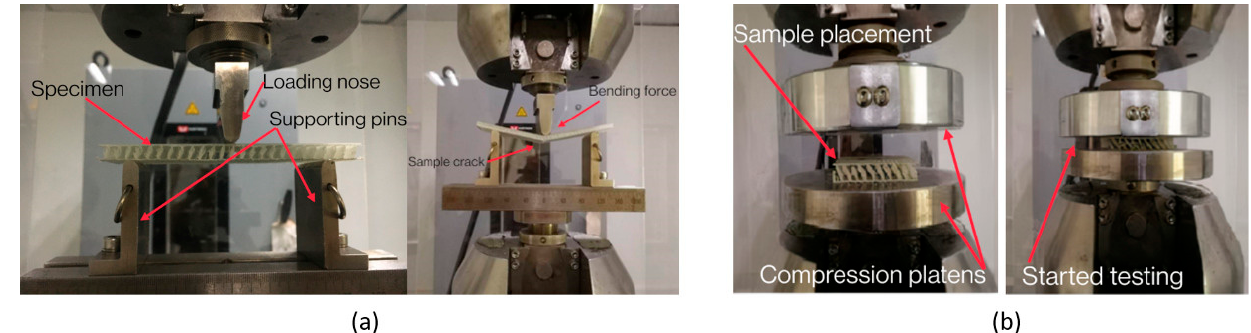
Figure 4. Equipment set ups for ( a ) bending and ( b ) flat compression experiments. At present, there is no unified test standard for testing the flat compression perfor- mance of glass fiber 3D spacer fabric composites in the industry. In this study, GB/T 1453-2005 “Sandwich structure or core flat compression performance test method” was selected based on the material characteristics and experimental equipment [17]. According to the standard, the test specimens were cut to a size of 60 × 60 mm. Five pieces were prepared for each group of standard specimen, as shown in Figure 5. The experiment was carried out on the INSTRON-8801 universal tester.